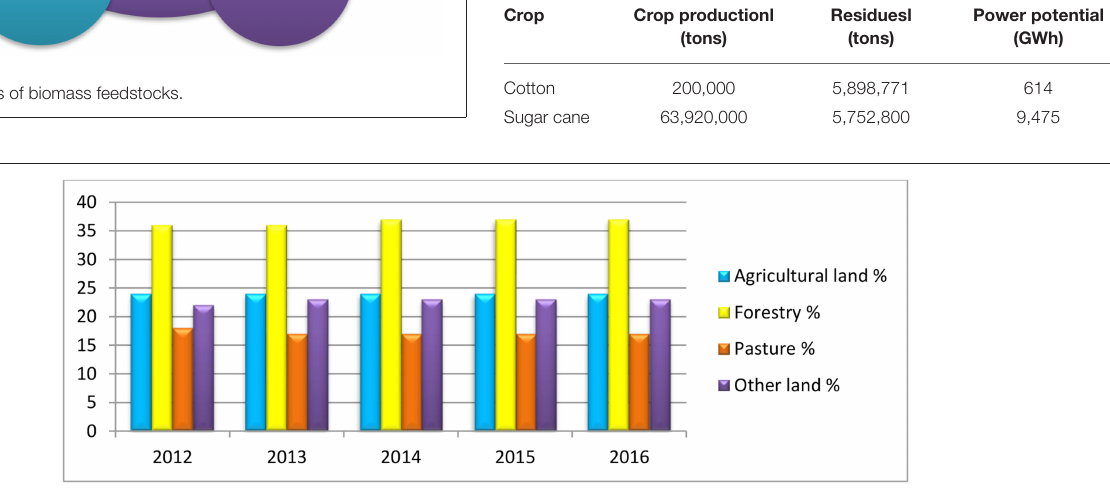
FIGURE 7 | Total land structure of